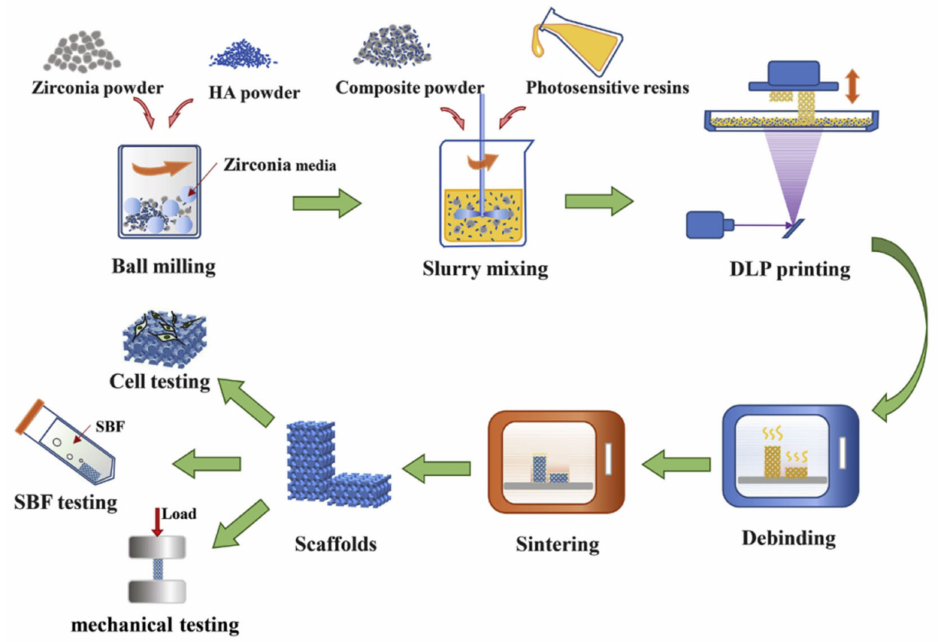
Figure 12. Illustration of the fabrication and testing process. Image used from Cao et al. [91], reprintedwith permission from Elsevier, copyright©